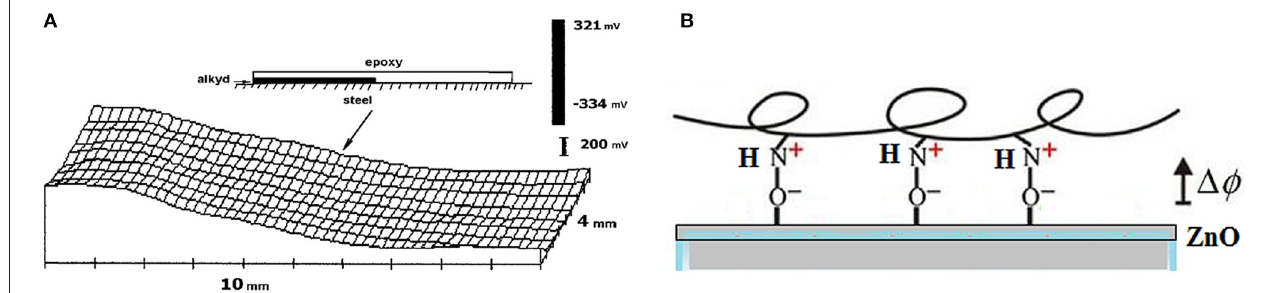
FIGURE 10 | (A) Potential distribution (mV vs. SHE) across a steel surface covered by epoxy-diamine (250 µ m thick, right hand side) and alkyd coatings (35 µ m thick, left hand side). Reprinted with permission from Elsevier (Nazarov and Thierry, 2004b). (B) Schematic of the interfacial interaction for epoxy